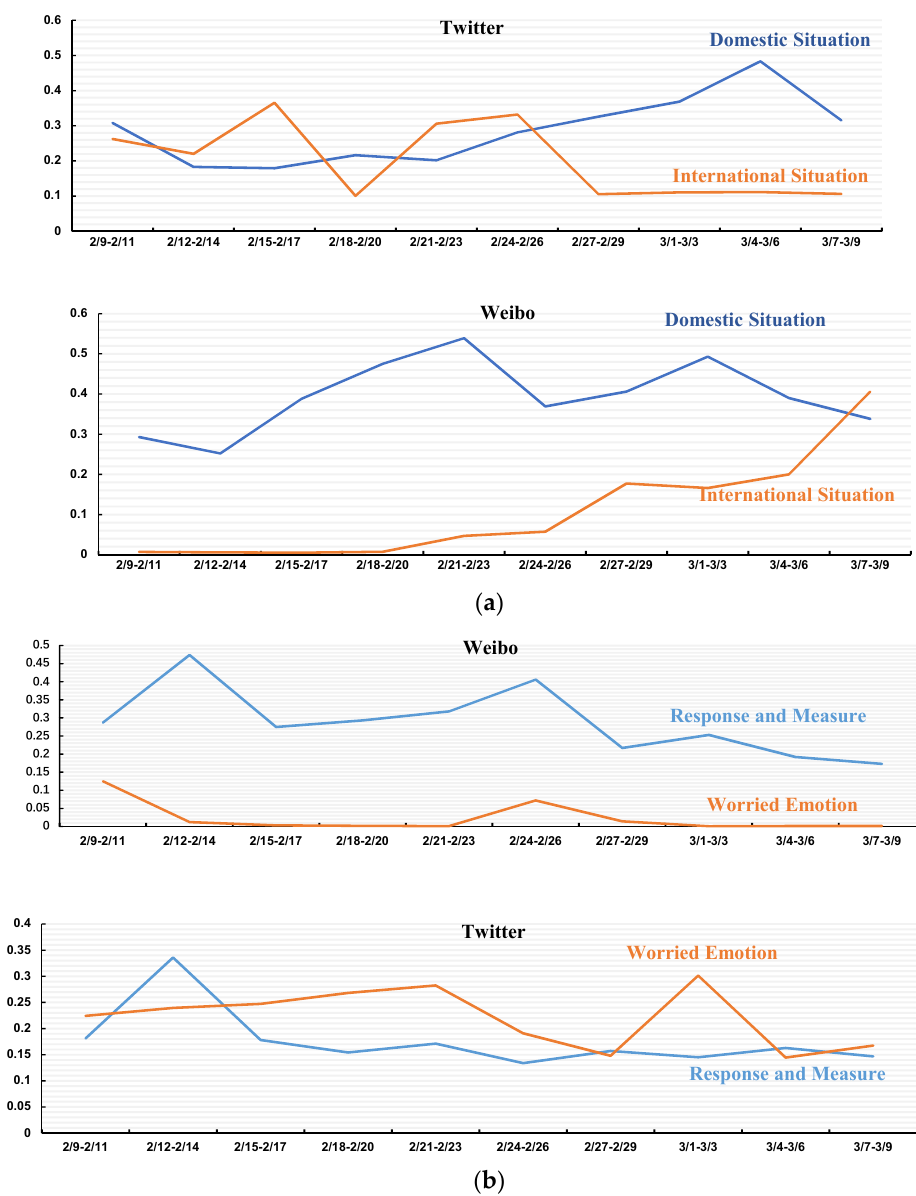
Figure 3. Issues ( a ): Domestic situation/international situation on Twitter and Weibo; Issues ( b ): Response and measure/worried emotion on Twitter and Weibo.